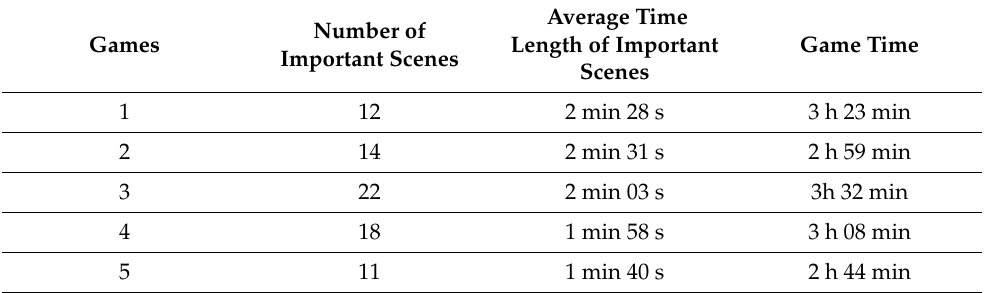
Table 1. Details of the baseball video dataset used in our experiment.